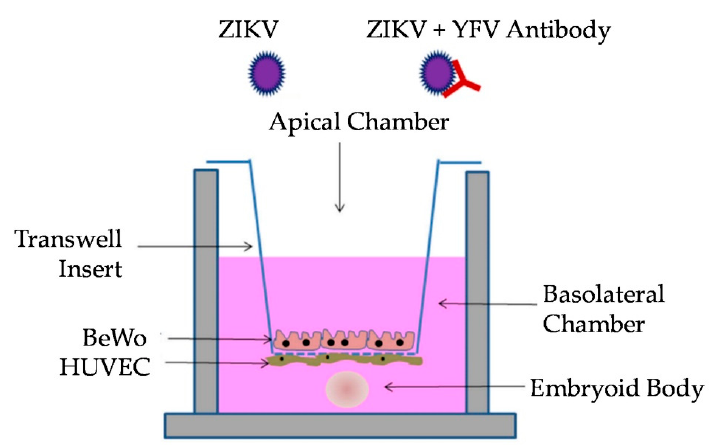
Figure 1. Experimental model of the transwell co-culture assay modified from Campagnolo et al. (2018) [37]. Co-cultures of BeWo, HUVECs, and embryoid body (EB) were apically infected with either Zika virus (ZIKV) or ZIKV + YFV (yellow fever virus) antibody.